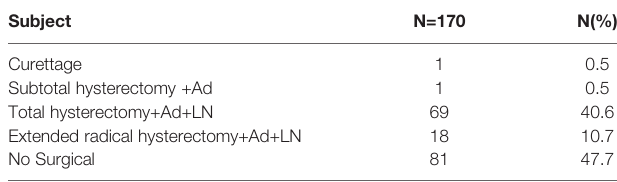
TABLE 1 | Patient characteristicso of neuroendocrine tumors (NETs)of the